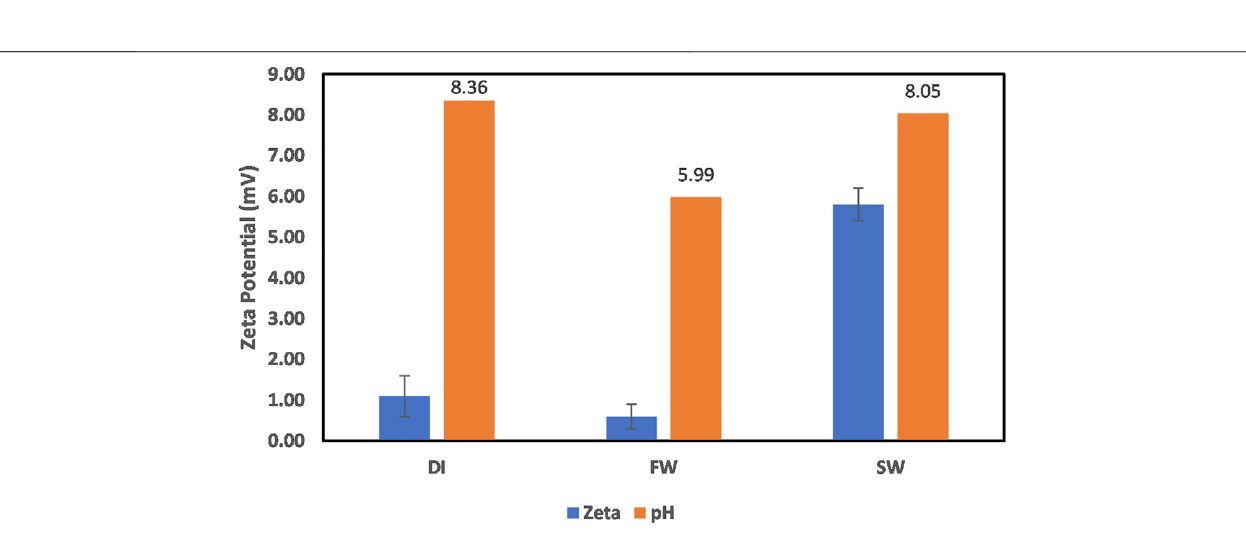
FIGURE 3 | Dolomite particle surface charge in DI, FW, and